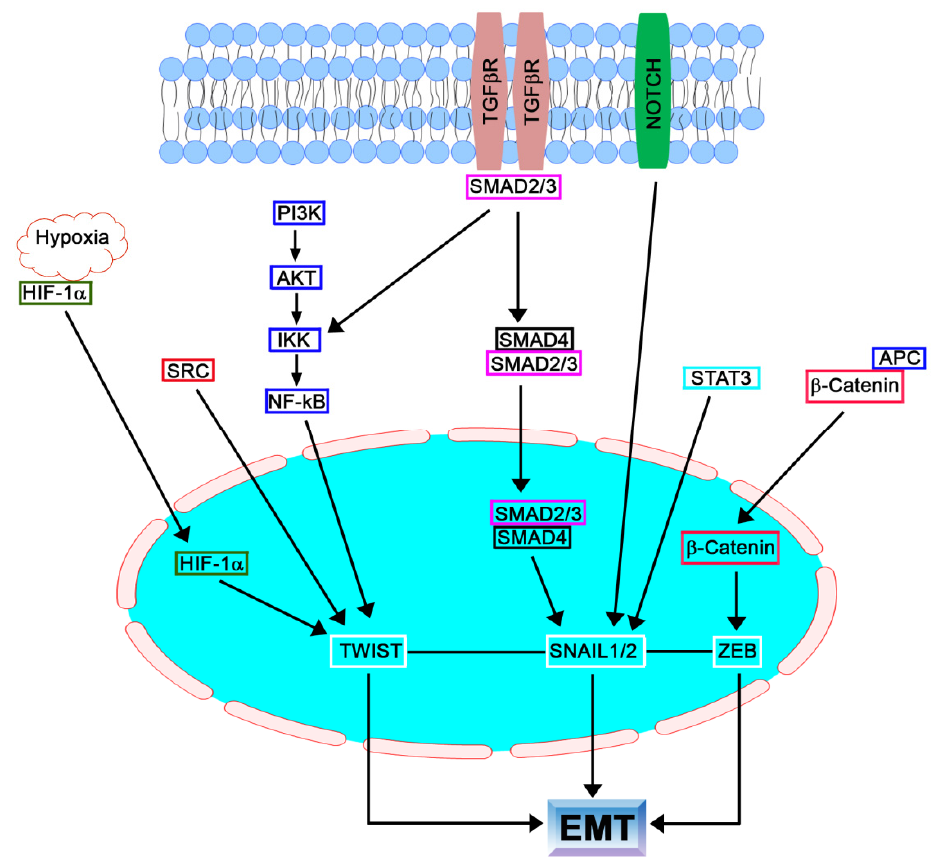
Figure 1. Schematic representation of the different actors and pathways leading to EMT induction.